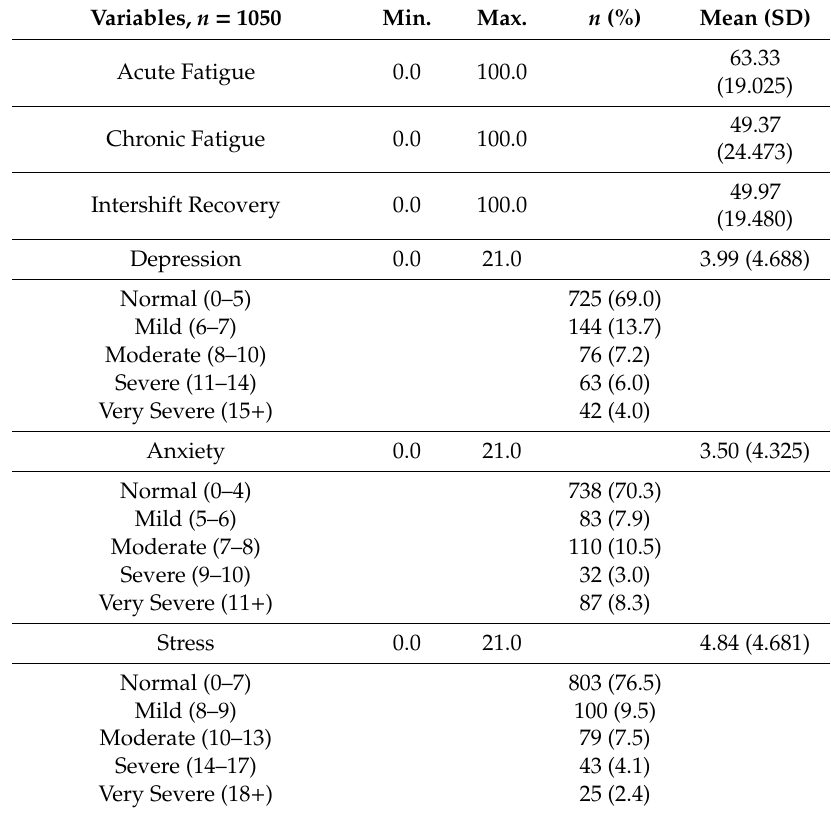
Table 4. Mental health